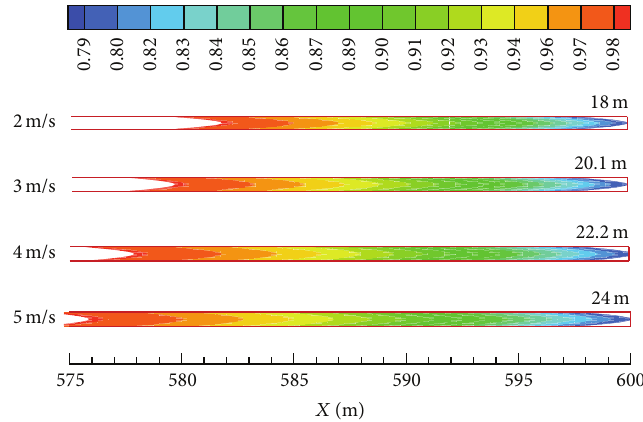
Figure 10: The maximum gas mixture length at different inlet rates.